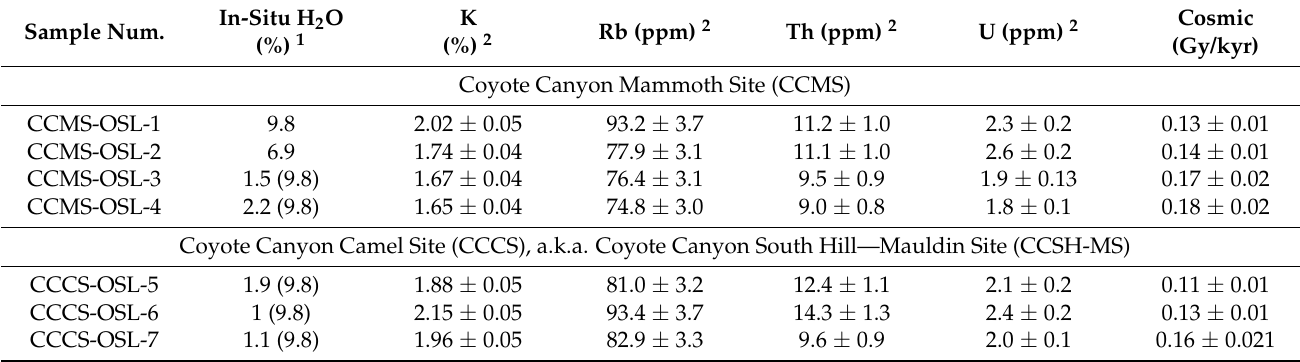
Table 3. Moisture content and radioelement concentrations for samples collected during exhumation of OSL samples. Sample Num.